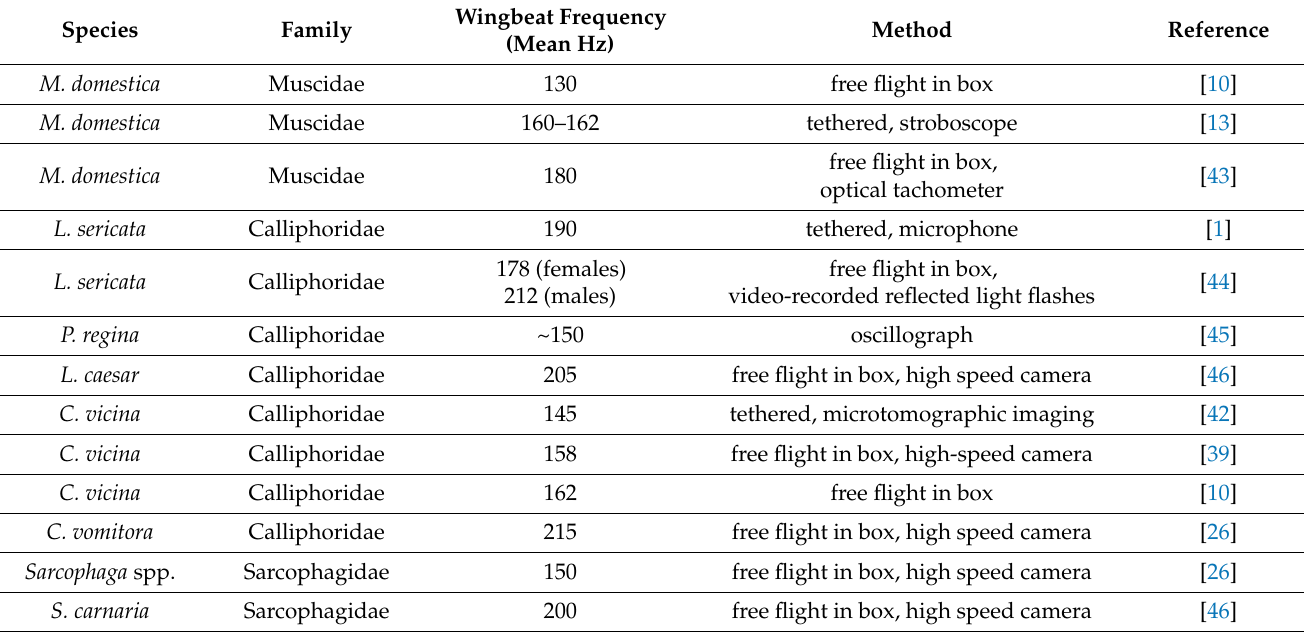
Table 1. Published wingbeat frequencies of calyptrate flies collected under various